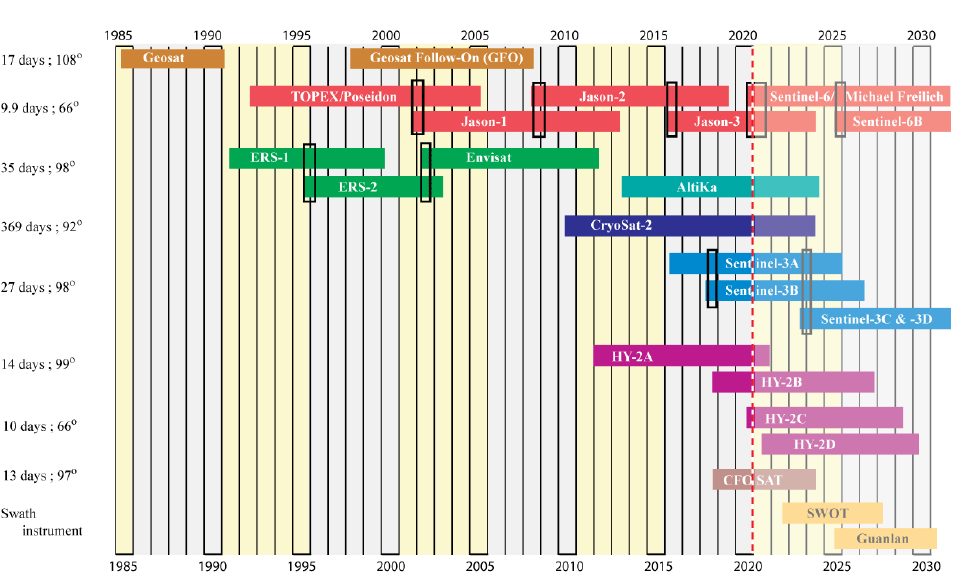
Figure 1. Gantt chart showing the altimetry missions since 1985, classified by their principal orbit (repeat period and inclination), which governs which validation sites are overflown. Investigating long-term trends requires that all the missions used be referenced to the same standard. The black boxes indicate tandem missions when a preceding satellite was used to calibrate a new mission. Note, ERS-1 was in a 3-day orbit for the early part of the mission, Geosat only assumed 17-day repeat after November 1986, while other missions were moved into geodetic phases for the latter years of their